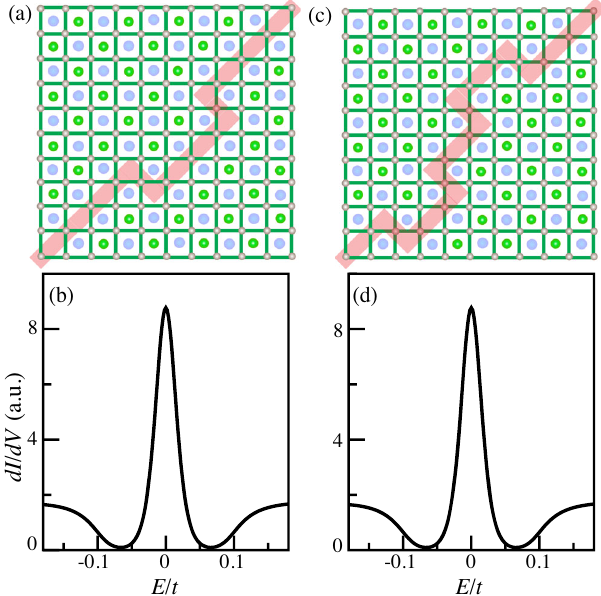
FIG. 6. Quasi-1D TSC along a nonstraight RALD. (a),(c) Schematics of two different zigzag line defects. The total length of the system along the (1,1) direction is 500 the segments are, from lower left to upper right, 104 ffiffiffi ffiffiffi ffiffiffi p p p 41 2 2 2 , , and 104 for (a) and 54 ffiffiffi ffiffiffi ffiffiffi p p p p 2 2 2 2 , 30 , , and 105 for (c). (b),(d) The corresponding LDOS at both ends of the nonstraight line defects, showing robust zero-bias peaks due to the zero-energy end states. The parameters used are μ 0 ¼ − 4 . 0 , μ d ¼ − 0 . 8 , t 0 2 ¼ 0 . 1 , t 1 ¼ 0 . 1 , Δ 1 ¼ 0 . 1 ,